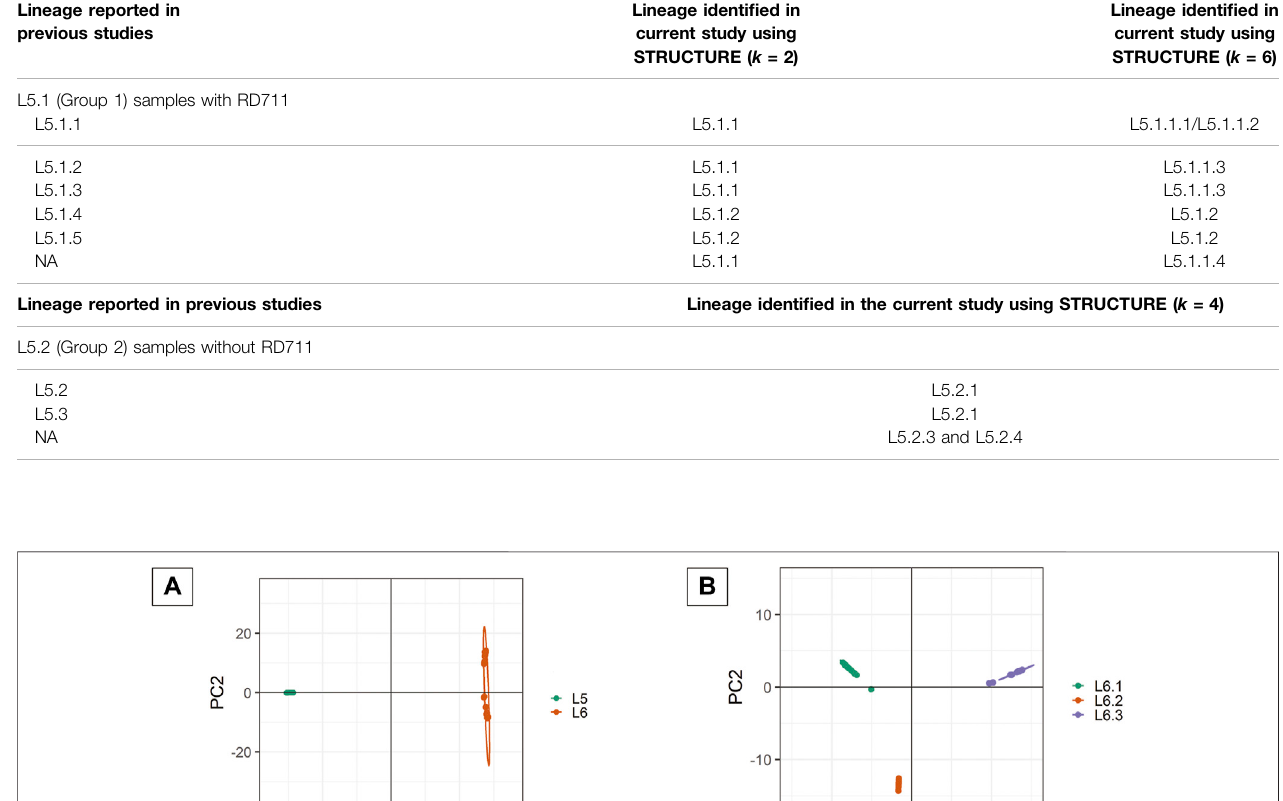
Lineage identi fi ed in current study